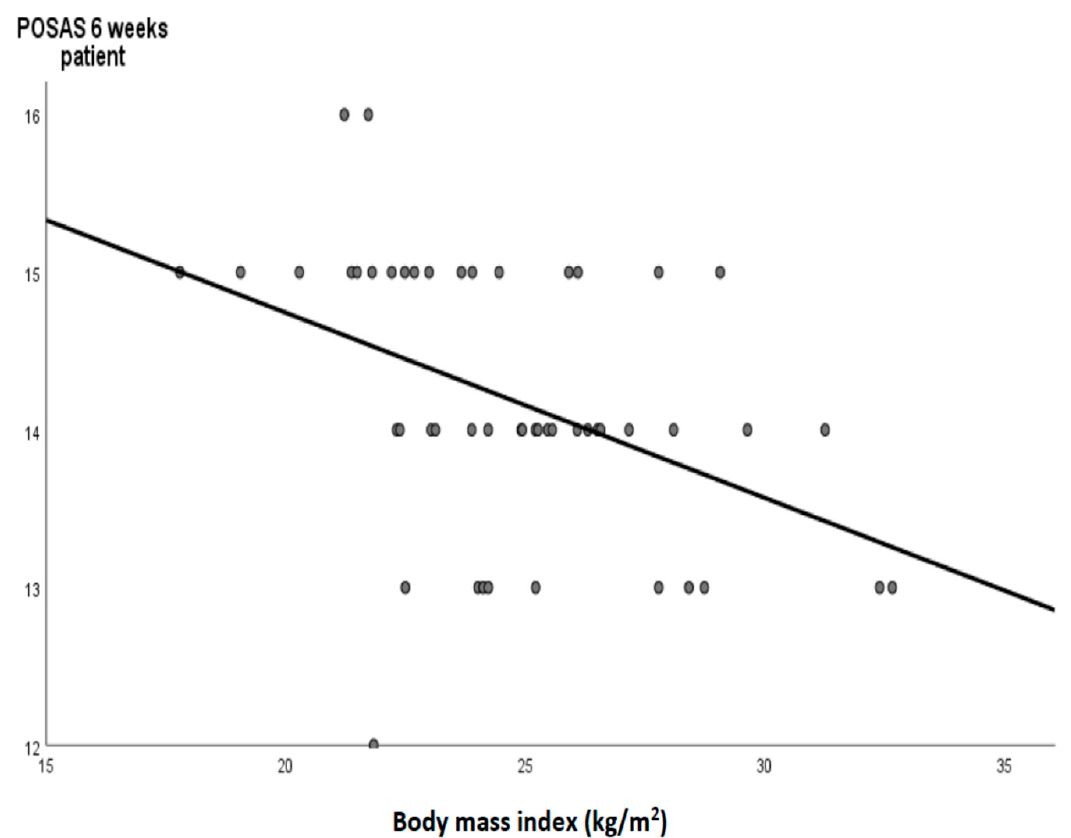
Figure 3. A regression graph (black line) and circles as a cases with the regression equation demon- strated a moderate correlation between the body mass index and POSAS score of the patient in the 6th week in the subgroup of glue wound closure subjects (Y= − 0.118X +